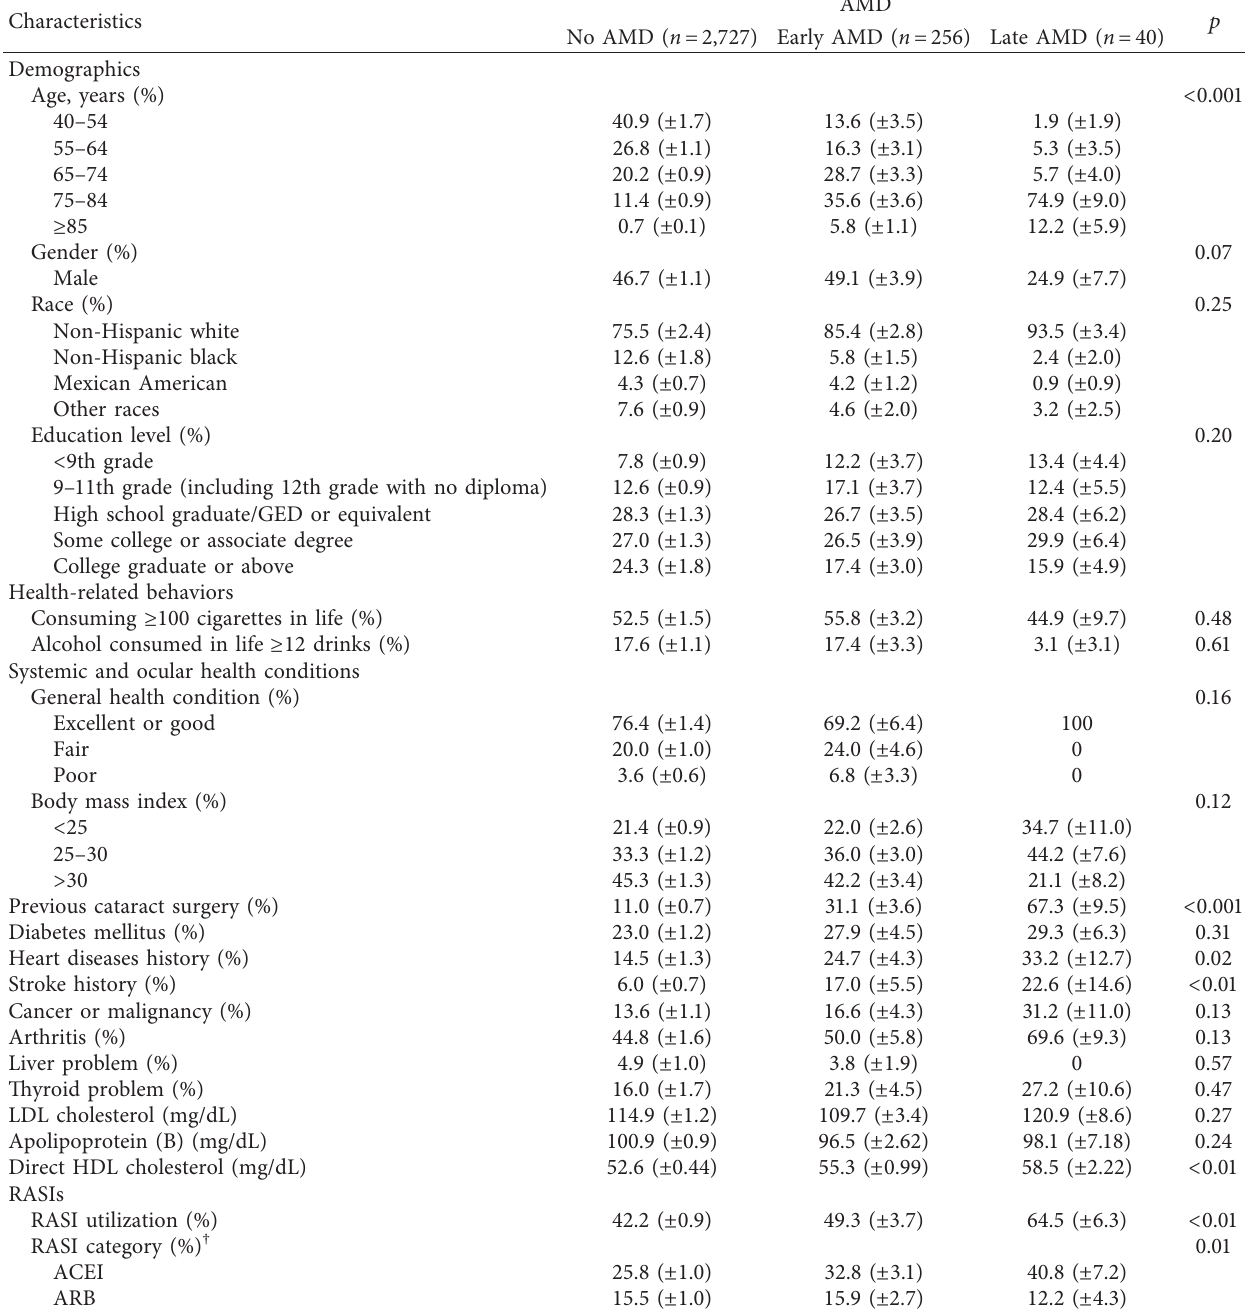
Table 1: Characteristics of the study